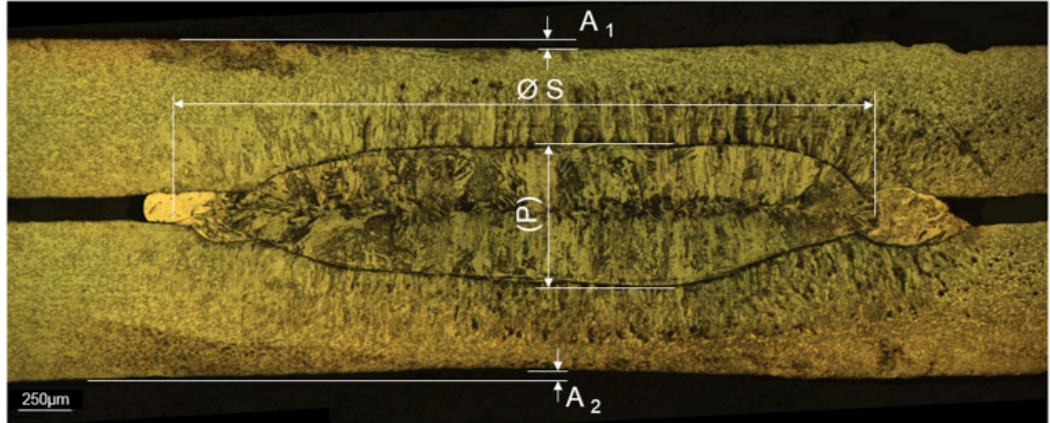
Figure 7. Example of macrography in relation to the spot welding process using additive manufacturing (AMSW).